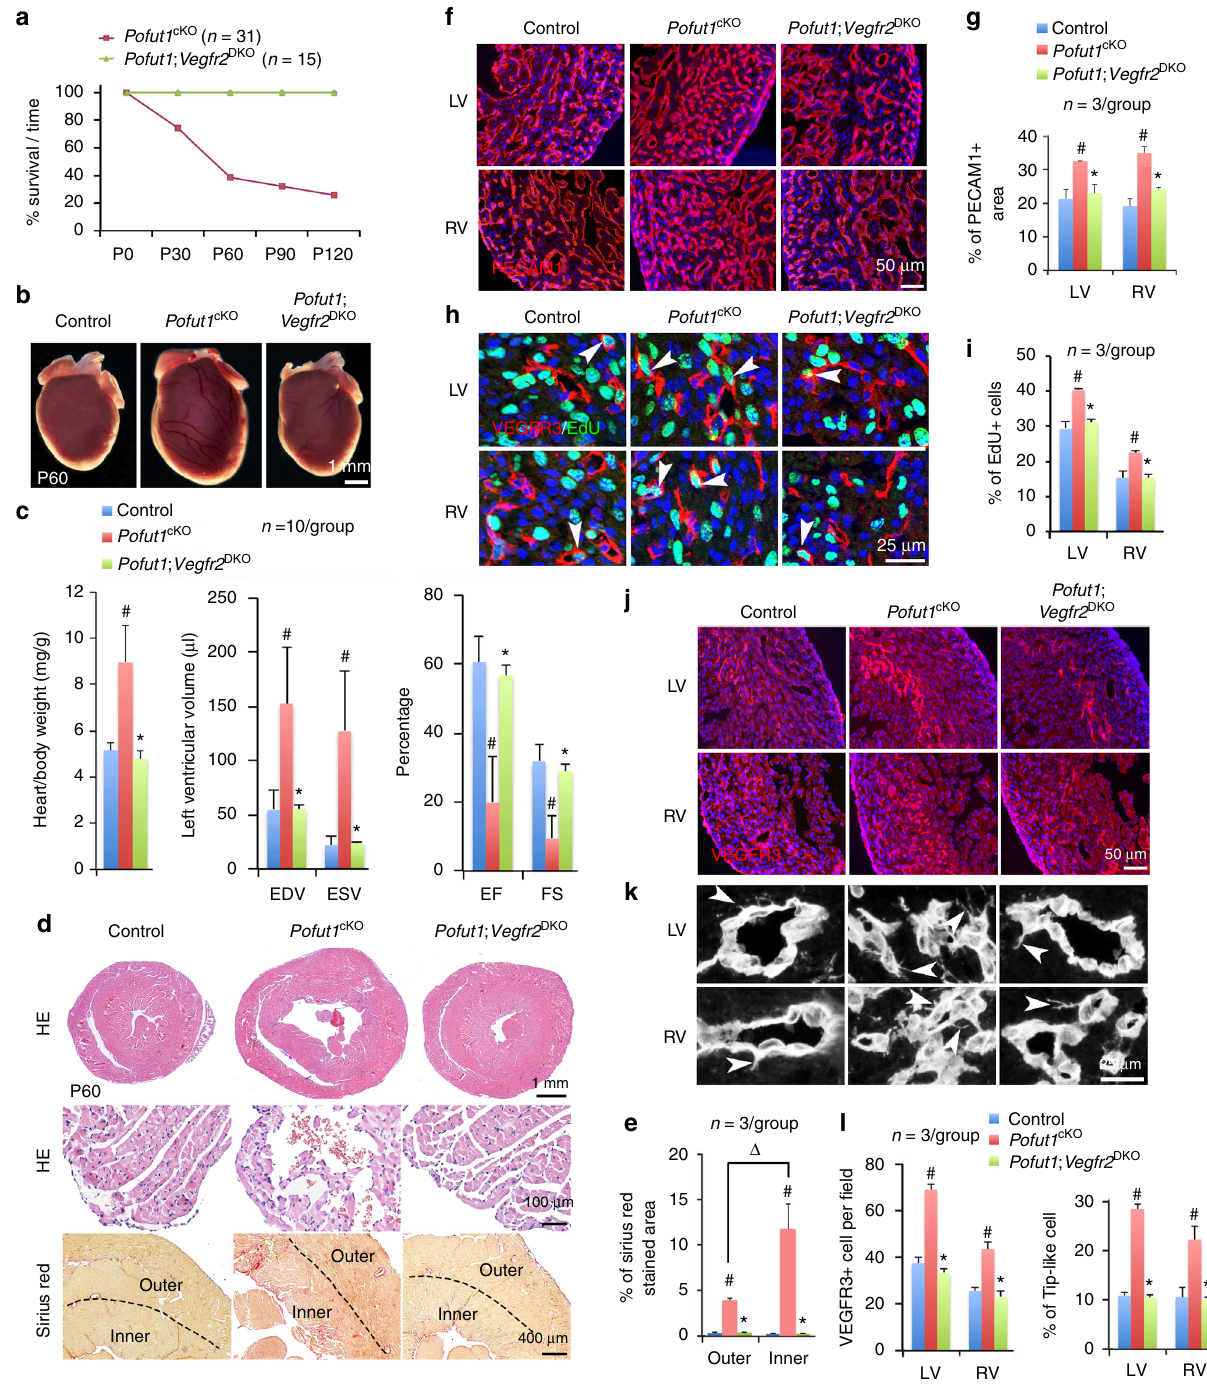
Fig. 6 VEGFR2 mediates POFUT1 function for coronary artery formation. a Survival curve of Pofut1 cKO and Pofut1;Vegfr2 DKO mice. b Gross view of P60 hearts. c Heart/body ratio of P60 mice. # p < 0.01 between control and Pofut1 cKO , * p < 0.01 between Pofut1 cKO and Pofut1;Vegfr2 DKO . Echocardiography shows that cardiac function of 2-month Pofut1;Vegfr2 DKO mice are restored. #,* p < 0.001. EDV/ESV, end diastolic/end systolic volumes; EF/FS, ejection fraction/fractional shortening. d Cardiac histology shows no sign of myocardial infarction in P60 Pofut1;Vegfr2 DKO hearts. e Quanti fi cation of Sirius Red staining. # p < 0.01 between control and Pofut1 cKO , * p < 0.01 between Pofut1 cKO and Pofut1;Vegfr2 DKO . Δ p < 0.01 between outer and inner. f , g PECAM1 staining shows restored coronary network in E16.5 Pofut1;Vegfr2 DKO hearts. h , i VEGFR3/EdU co-staining shows reduced proliferation of angiogenic cells ( arrowheads ) to normal levels in P60 Pofut1;Vegfr2 DKO hearts. #,* p < 0.05. j , l VEGFR3 staining shows a restored number and distribution of angiogenic cells in E16.5 Pofut1;Vegfr2 DKO hearts. Mean ± SD; #,* p < 0.001. k , l PECAM1 staining shows a restored number of tip-like cells ( arrowheads ) in E16.5 Pofut1;Vegfr2 DKO hearts. Mean ± SD; #,* p <